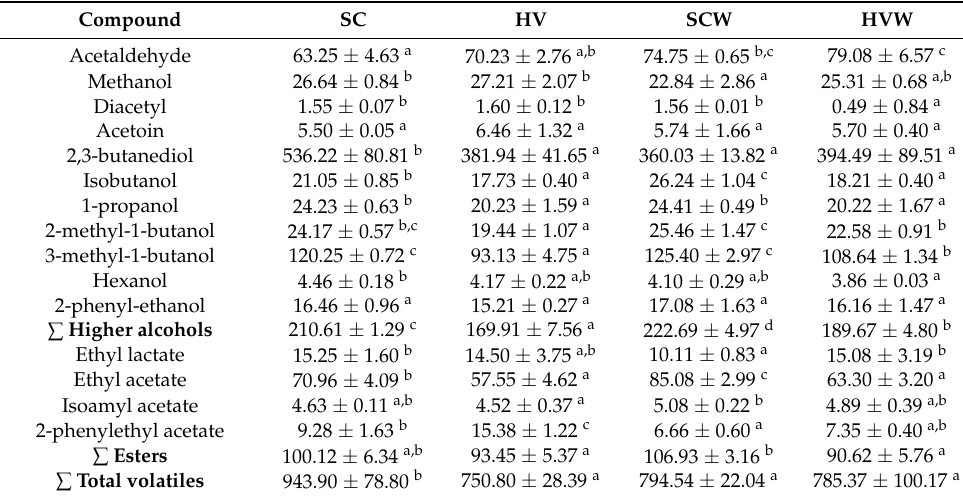
Table 3. Volatile compounds produced by fermentation (mg/L), measured by GC-FID. Mean ± standard deviation of three